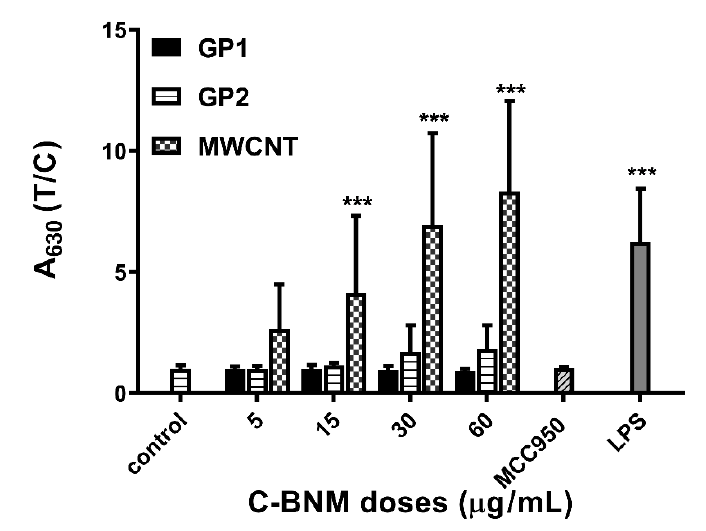
Figure 8. Activation of NLRP3 in isolated monocytes after 24 h exposure was measured as conversion of proIL-1 β to IL-1 β , which was detected using HEK-Blue ™ IL-1 β cells. Untreated isolated monocytes were used as a negative control. LPS was used as positive standard of NLRP3 induction. MCC950 was used as specific inhibitor of MWCNT induction of NLRP3. The symbol *** p < 0.001 highlights the statistical significance as compared to the corresponding control.